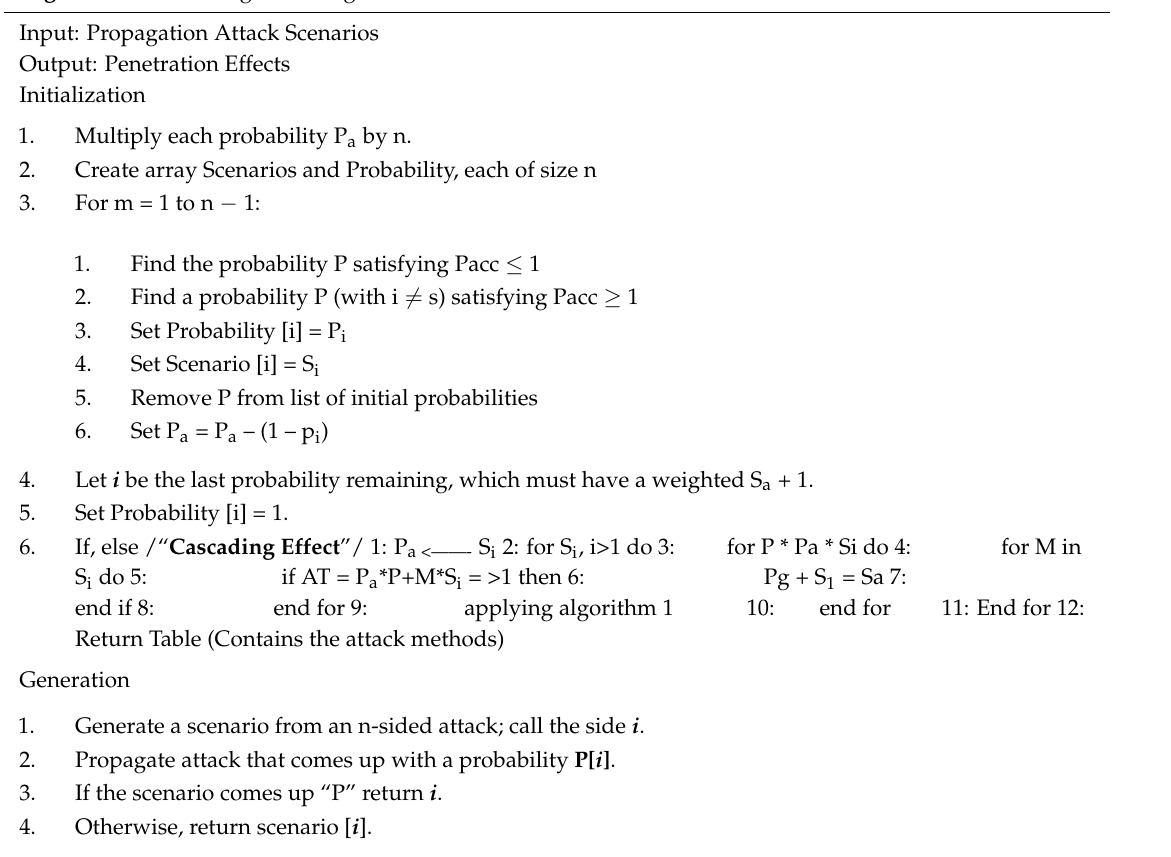
Algorithm 1 Cascading Effect